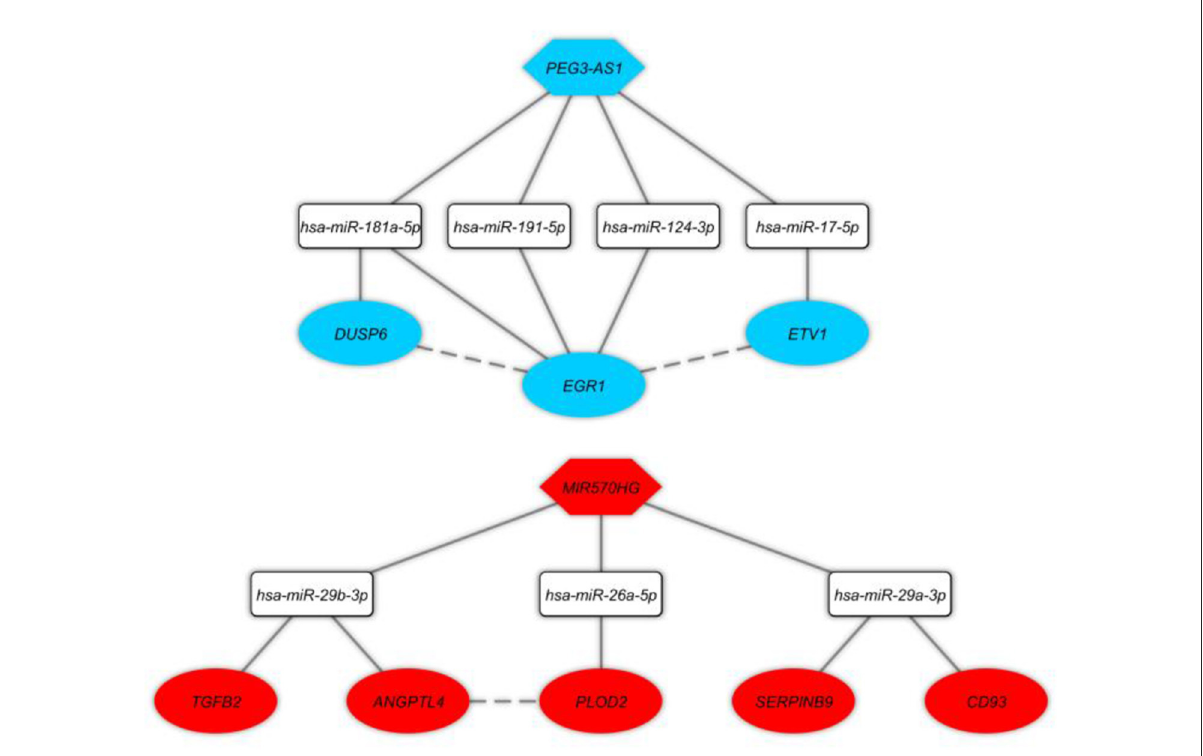
FIGURE4 Long non-coding RNA (lncRNA)-associated competing endogenous RNA axes. Red and blue represents upregulation and downregulation of ceRNAs, respectively. LncRNAs, miRNAs, and mRNAs are represented by hexagon, round rectangle, and ellipse, respectively. The dash lines between nodes represent the interactions between proteins.